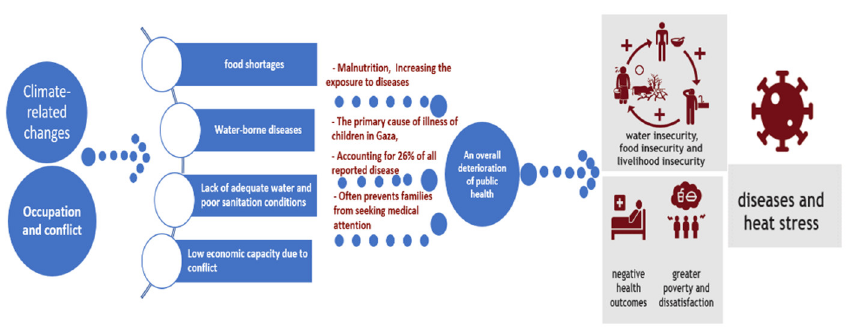
Figure 6. Impact of climate change and occupation on the Palestinians’ health (Source: created by Authors, data cited in the text).